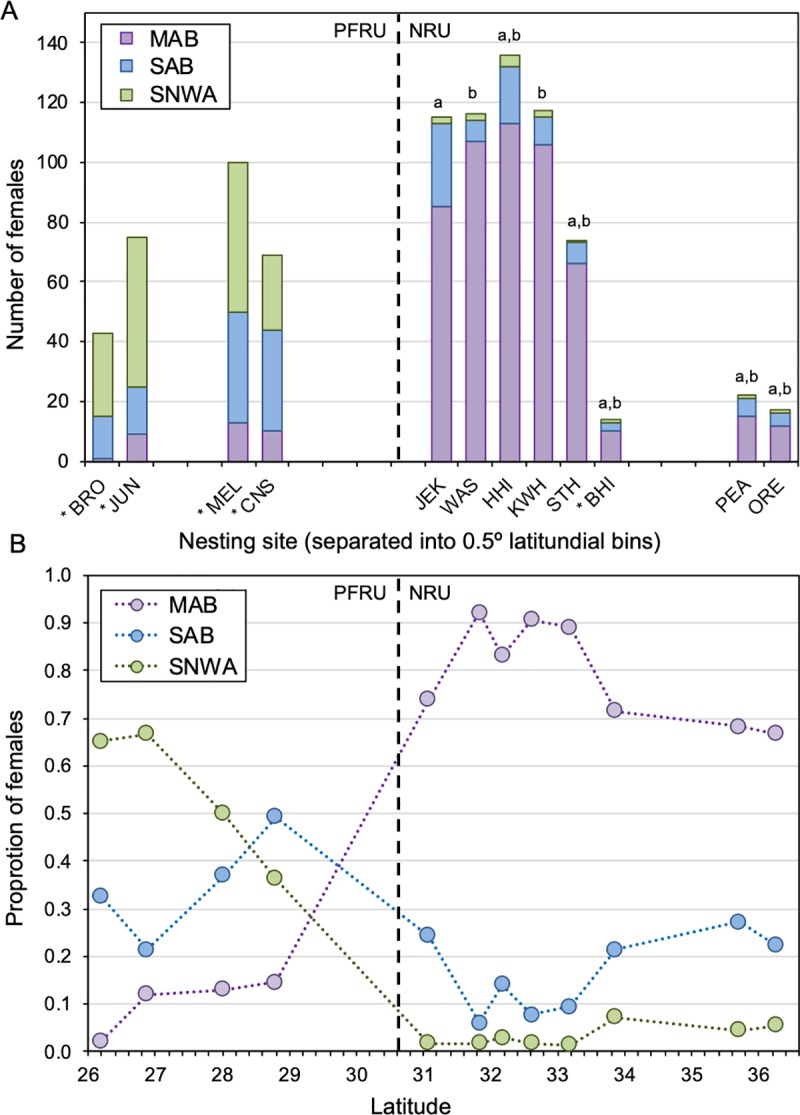
Latitudinal variation in foraging-area origin among nesting sites.(A) Bar chart and (B) line graph displaying latitudinal variation among nesting sites in the proportion of female loggerheads originating from three different foraging areas: MAB, Mid-Atlantic Bight; SAB, South Atlantic Bight; SNWA, Subtropical Northwest Atlantic. (A) Letters indicate statistical differences among eight nesting sites in the Northern Recovery Unit (NRU): ORE, north of Oregon Inlet; PEA, Pea Island; BHI, Bald Head Island; STH, South Island; KWH; Kiawah Island; HHI, Hilton Head Island; WAS, Wassaw Island; JEK, Jekyll Island. Asterisk indicates previously published foraging-area assignments for females nesting at BHI and four nesting sites in the Peninsular Florida Recovery Unit (PFRU: CNS, Canaveral National Seashore; MEL, Melbourne Beach; JUN, Juno Beach; BRO, Broward County beaches) that were included because foraging areas were assigned using the same training data and statistical constraints [14]. (B) There were no significant trends between the latitude of NRU nesting sites and the proportion of females originating from each of the three different foraging areas (simple linear regression; one analysis for each of the three foraging areas).